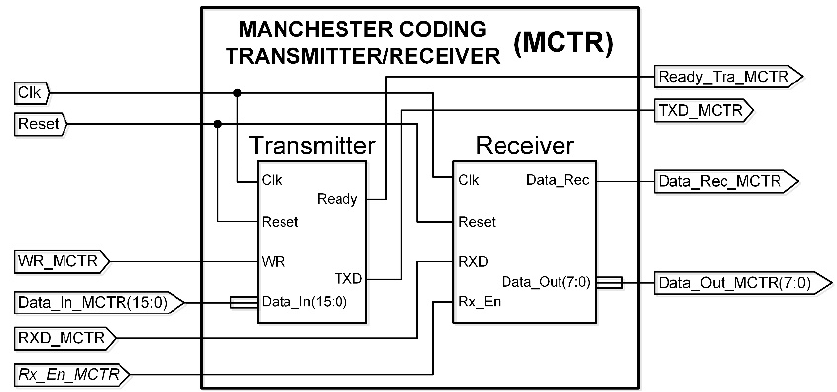
Figure 10. Manchester Coding Transmitter / Receiver (MCTR) Entity.